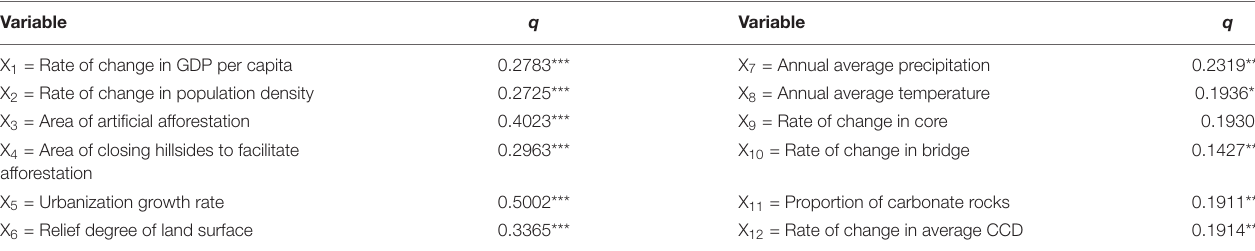
TABLE 3 | Factors influencing the q -value for the normalized difference vegetation index (NDVI) trend in Guizhou, 2005–2018. Variable